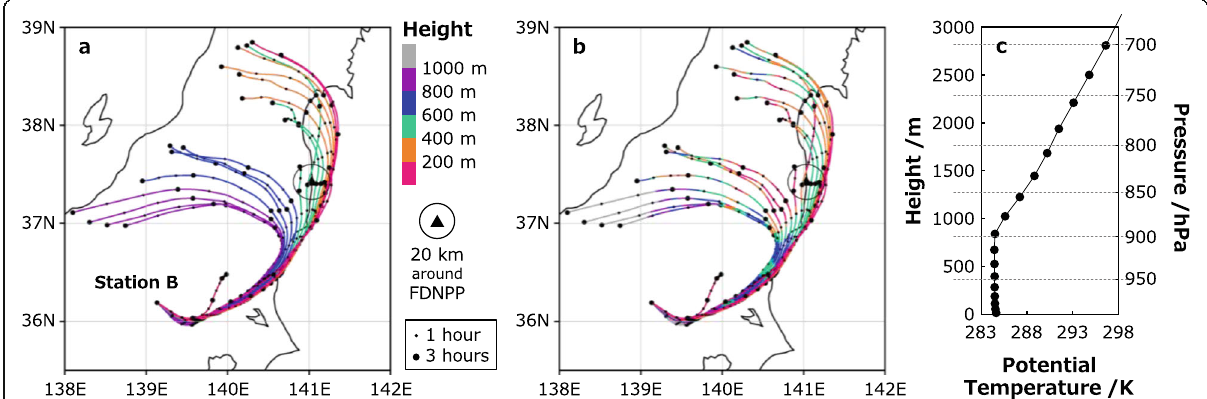
Fig. 4 Backward trajectories calculated for air parcels placed above station B at 1200 JST 15 March 2011. The trajectories are color-coded ( a ) to distinguish heights (m) of the parcels at station B and ( b ) according to their heights at each time step. Small and large dots on the trajectories indicate intervals of every hour and 3 h, respectively, after the calculation start time. c Vertical profile of potential temperature (K) above station B at the trajectory start